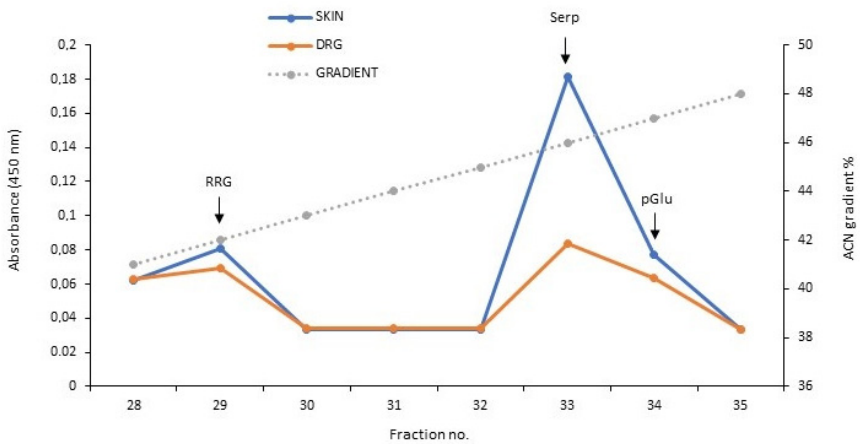
Figure 2. RP-HPLC and EIA for serpinin-like immunoreactivity from extracts of rat DRG and skin. In DRGs (brown line), there were two peaks present, in fraction 29 and 33 and a shoulder in fraction 34 representing serpinin-RRG (“RRG”), free serpinin (“Serp”) and pGlu-serpinin (“pGlu”), respectively. In the skin (blue line), the immunoreactivities in fraction 29 and 34 were approximately equal to that in DRGs, but the immunoreactive peak in fraction 33 was much higher than in DRGs. The elution positions of these three serpinins are indicated by arrows.